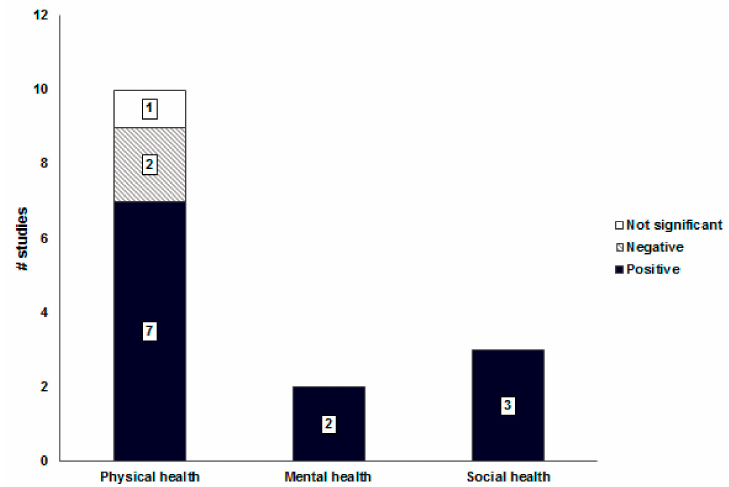
Figure 6. Associations between neighborhood facilities and health-related